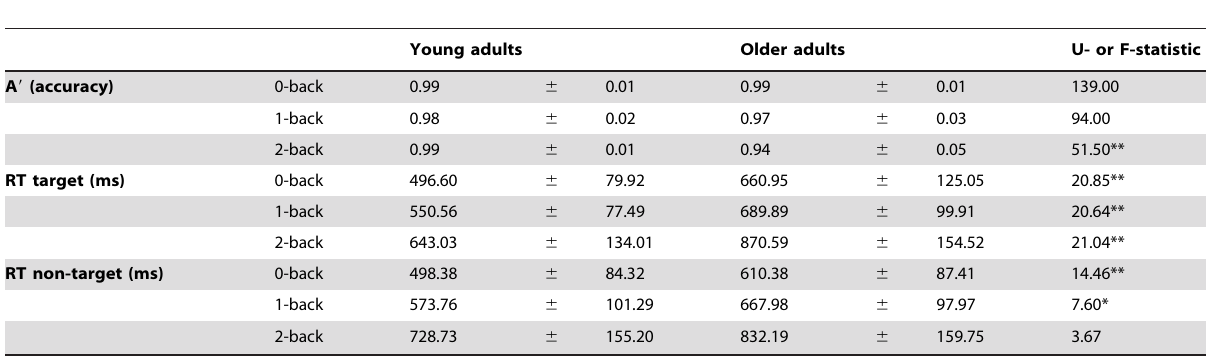
Table 1. Accuracy and reaction times (Mean 6 SD) for the verbal n-back